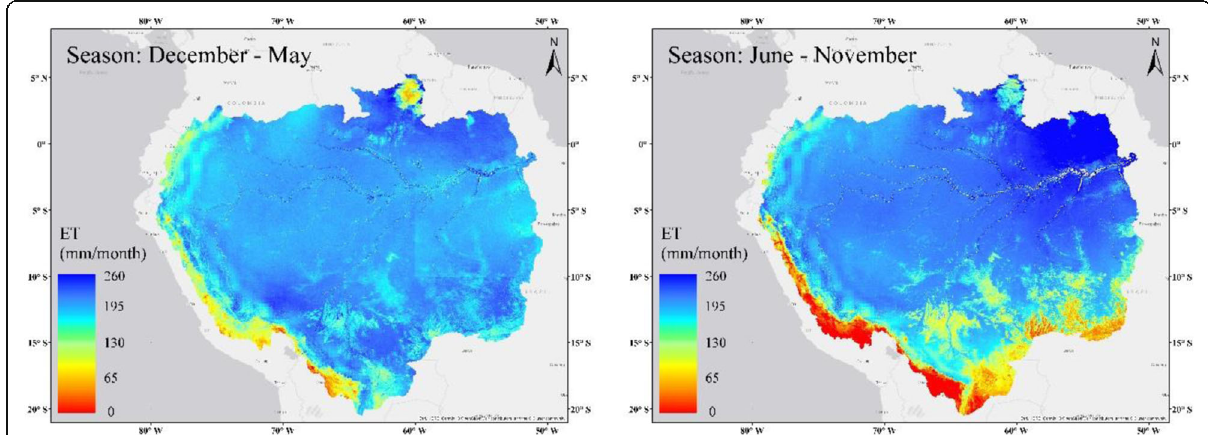
Fig. 10 Seasonal ET over the period 2003 to 2013 based on